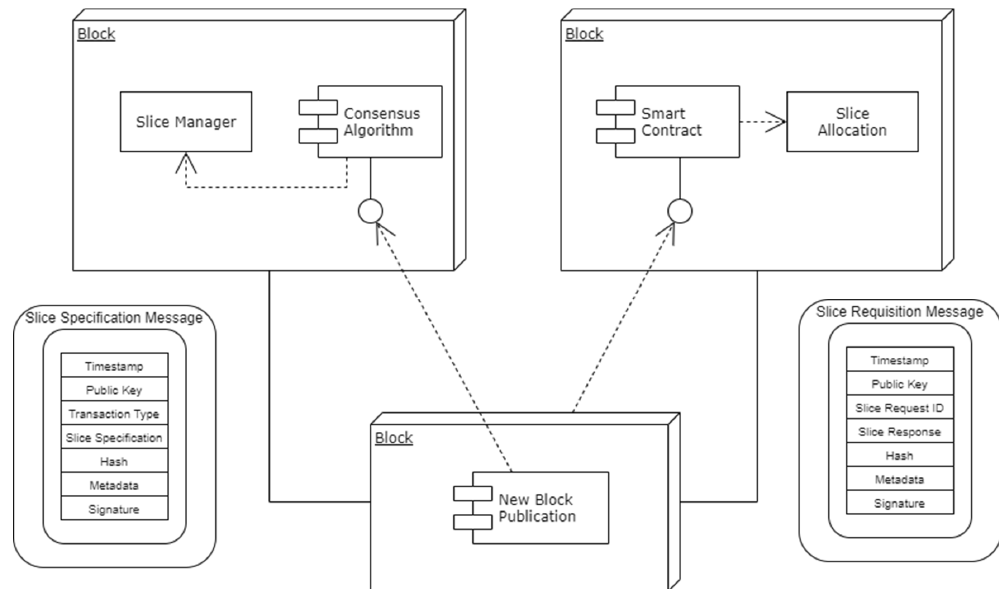
Figure 4. BENS-B5G model.